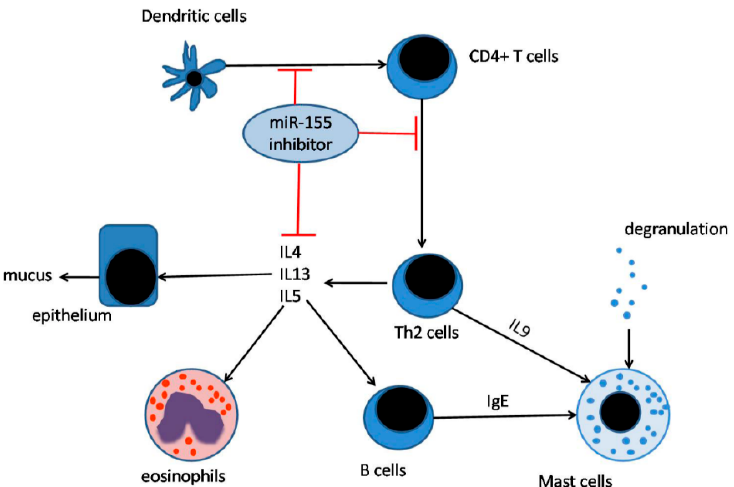
Figure 2. Anti-miR-155 activity in inflammation. miR-155 is able to regulate Th2 inflammation via three major pathways: (i) Prevention of antigen presentation by dendritic cells (DCs); (ii) inhibition of Th2 cell differentiation; and (iii) downregulation of Th2 cell secretion of IL-4, IL-5, and IL-13. Thus, anti-miR-155 could be a novel therapy for Th2 immune response-induced human diseases, such as asthma.